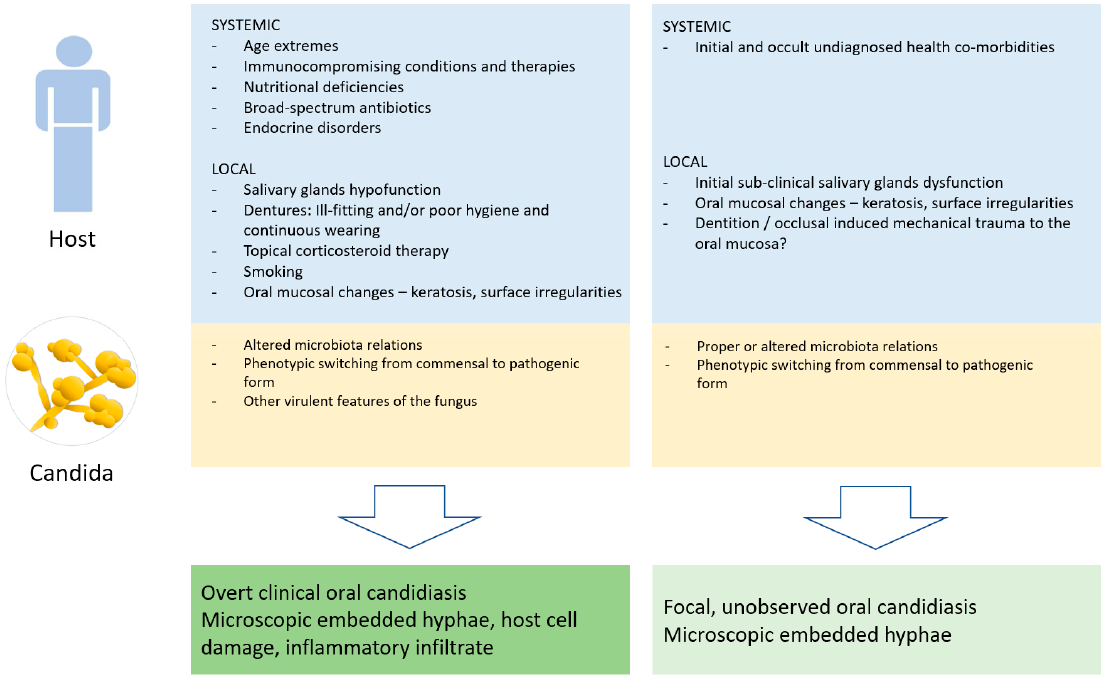
Figure 4. Interactions between host- and candida-related factors and the clinical outcomes.